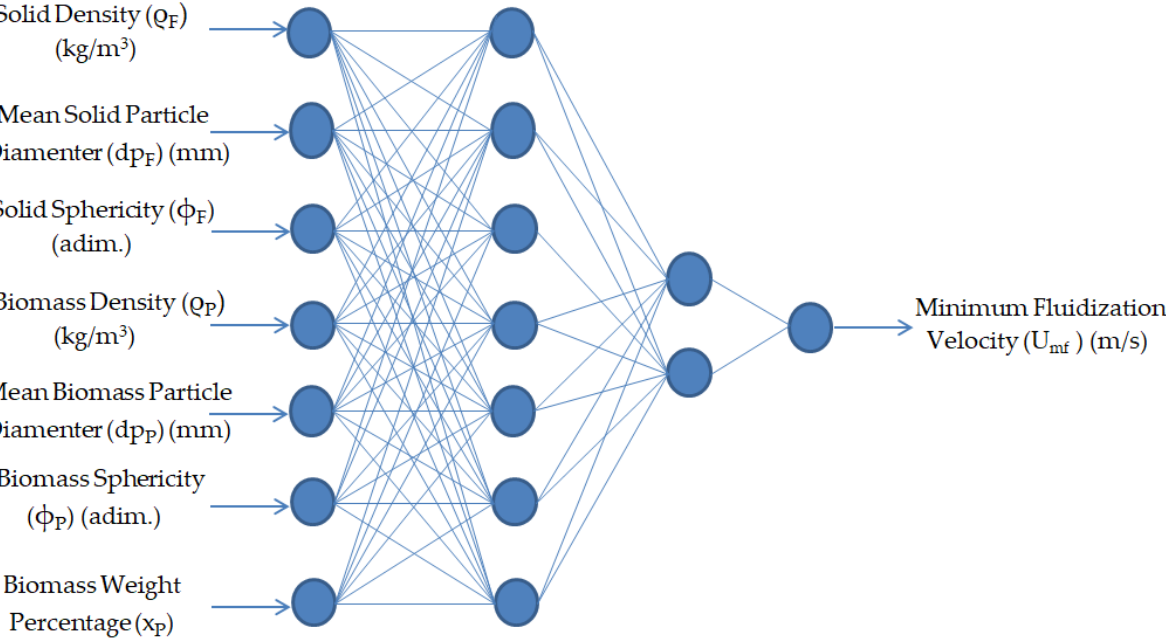
Figure 1. ANN-Model 2 (bias inputs are omitted from the figure for clarity). Model 1 has the same architecture but without the two sphericities as inputs.